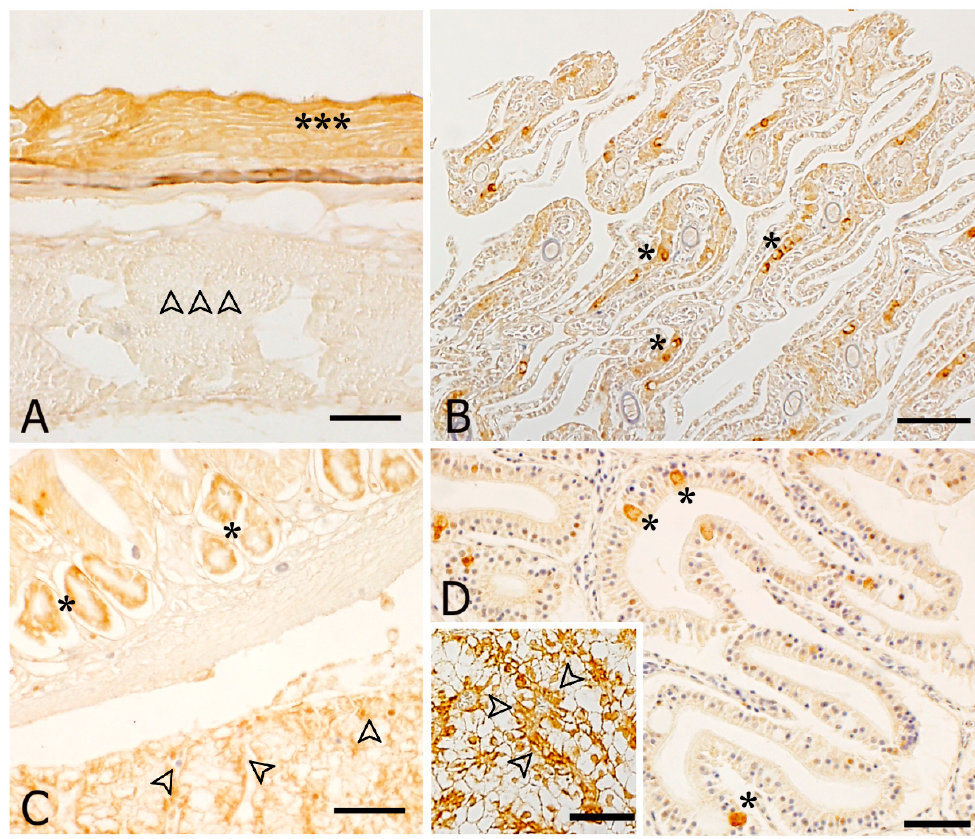
Figure 4. Immunohistochemical localization of HSP70 in Sparus aurata . All panels are counterstained with haematoxylin. ( A ) control fish . HSP70 immunoreactivity in the epithelium of the skin (asterisks); the lateral muscle is negative (arrowheads); ( B ) control fish . The epithelium lining both primary and secondary lamellae shows an immunoreactivity (asterisks); ( C ) thermal stressed fish. Gastric pits (asterisks) and liver parenchyma (arrowheads) exhibit an immunopositivity to HSP70 antibody; ( D ) ammonia stressed fish and as inserted a salinity stressed fish. Intestinal rodlet cells (asterisks) and hepatocytes are immunopositive (arrowheads). Bars: 200 μ m for all panels.